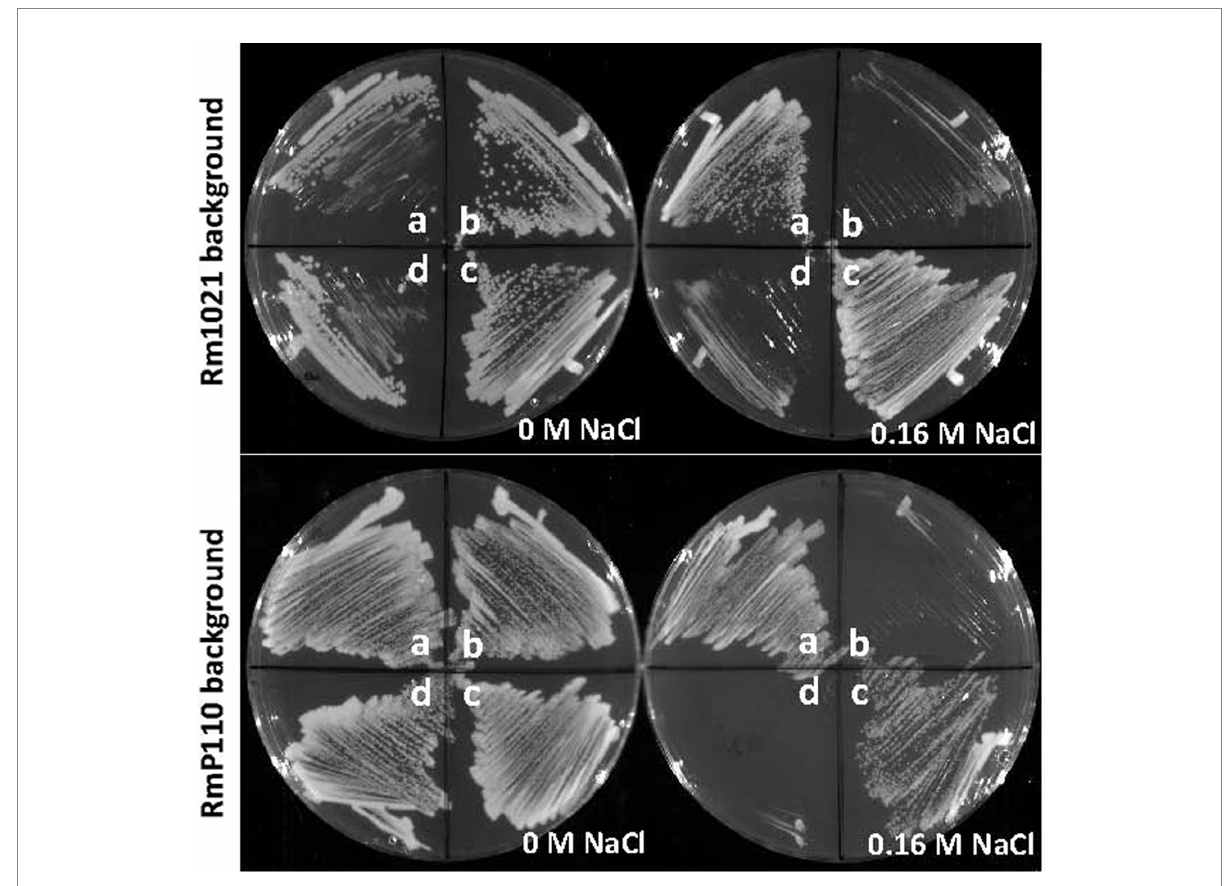
FIGURE 1 Salt-sensitive phenotype of srlA deletion strains. srlA was deleted in two wt host backgrounds: Rm1021 (top plates) and RmP110 (bottom plates) generating strains NB1903 and NB1854, respectively. Sectors a–d for all plates are as follows: (A) , wt strain; (B) , ∆ srlA strain; (C) , ∆ srlA strain complemented with pEB60; (D) , ∆ srlA strain complemented with pEB66. Strains NB1903 and NB1854 fail to grow in LB medium supplemented with 0.16 M NaCl (sectors b). pEB60 carries the wt srlA ORF and complements the salt sensitive phenotype of a genomic srlA deletion (sectors c). pEB66 carries the srlA ORF with a 52 codon deletion and fails to complement the salt sensitive phenotype of a genomic srlA deletion (sectors